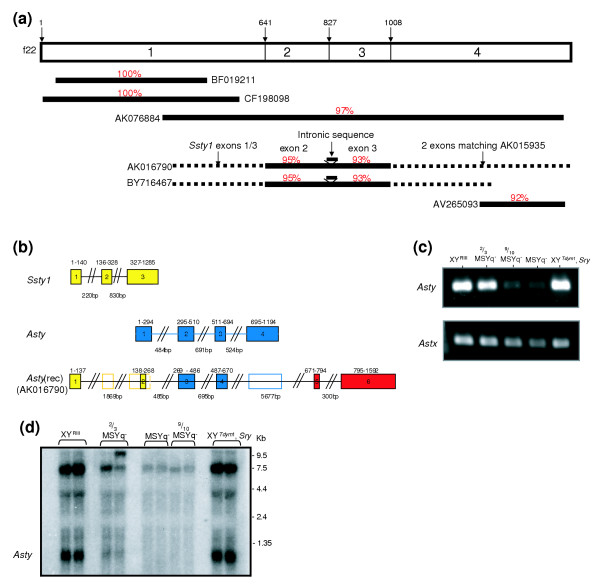
Identification of the novel MSYq encoded transcripts Asty and Asty(rec). (a) Testis transcripts identified from a BLAST (basic local alignment search tool) with the arrayed X encoded Astx cDNA clone 8832_f_22. BF019211, CF198098 and AK076884 are X encoded transcripts, whereas the rest are Y encoded transcripts. The Y encoded transcripts AK016790 and BY716467 include exons that do not derive from Asty (including two exons matching Ssty1). We refer to these transcripts as Asty(rec) because they derive from novel 'recombinant' loci on MSYq. For all the transcripts the percentage sequence identity is given for those regions that match the microarrayed clone. (b) The structure of the Asty(rec) locus encoding AK016790. The exons included in AK016790 are indicated by filled color coded rectangles and the inter-exonic distances are given in base pairs. The position of other Ssty1 and Asty exons not included in the AK016790 transcript are also indicated. (Note that the Ssty1 exon 3 is truncated in the Asty(rec) locus.) The two exons colored red are those that match the previously described transcript AK015935. (c) Reverse transcriptase polymerase chain reaction of testis cDNA with primers designed to specifically amplify Asty/Asty(rec) or Astx transcripts. It is clear that it is the Asty/Asty(rec) transcripts that are preferentially reduced in the MSYq deficient males. (d) Northern blot of total testis RNA probed with an Asty exon 4 probe and with an actin probe as a loading control. Transcripts ranging in size from about 1 kilobase (kb) to more than 9.5 kb are detected with the Asty exon 4 probe; the approximately 7.5 kb and larger transcripts definitely derive from the Asty/Asty(rec) loci (see text) and (in contrast to AK016790) must include Asty exon 4.